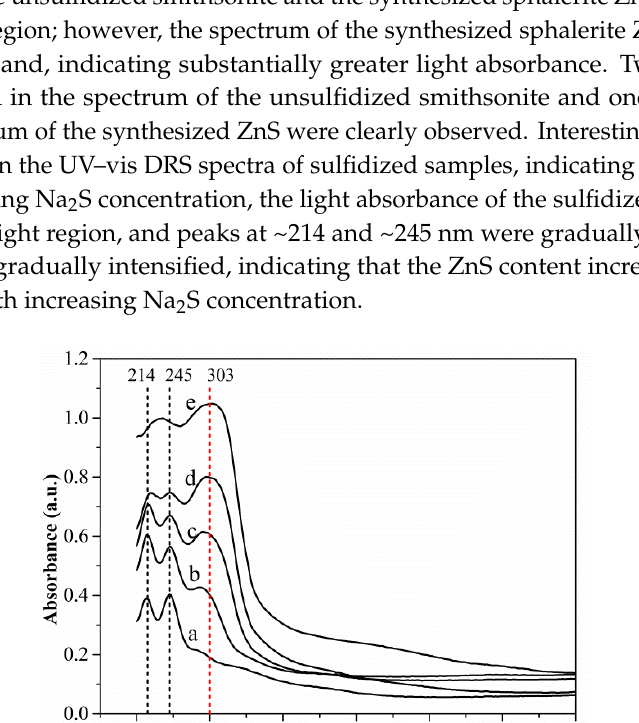
Figure 8. ( a ) Height profiles. ( b ) Phase shifts.